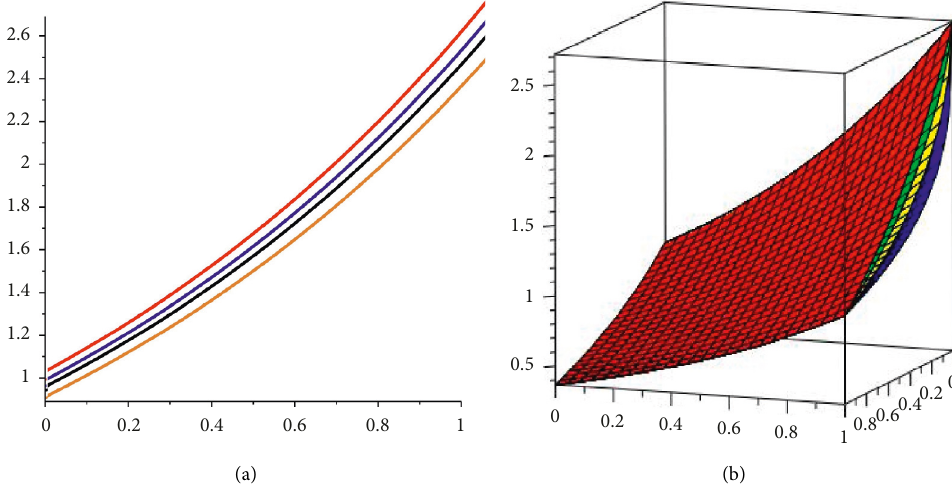
Figure 4: Figure of (a) and (b) at various fractional-order of Example